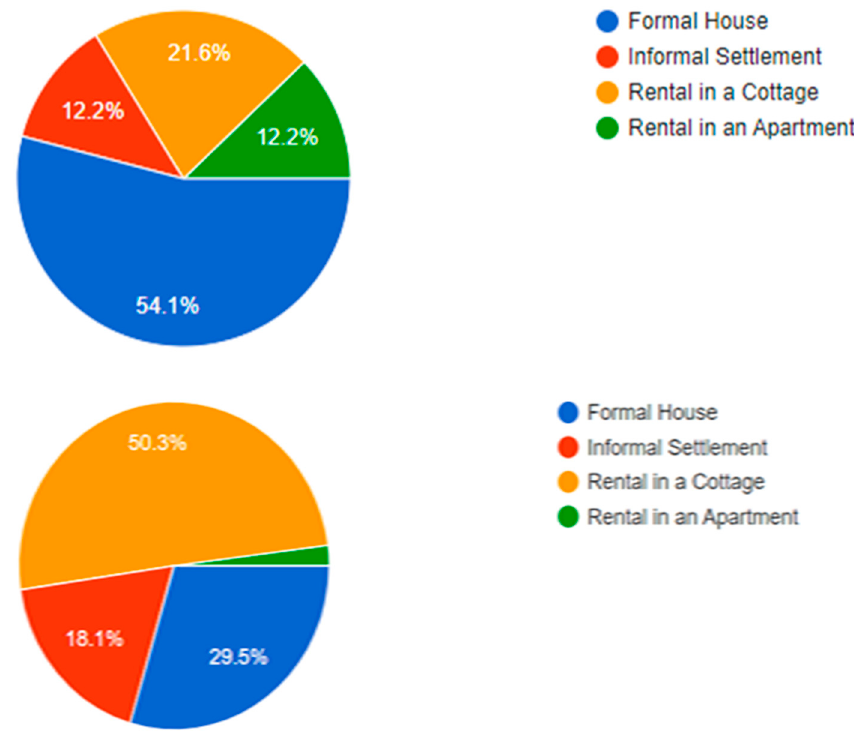
Figure 1. Dwelling Type in KwaDukuza and eThekwini. Source: Author’s own.